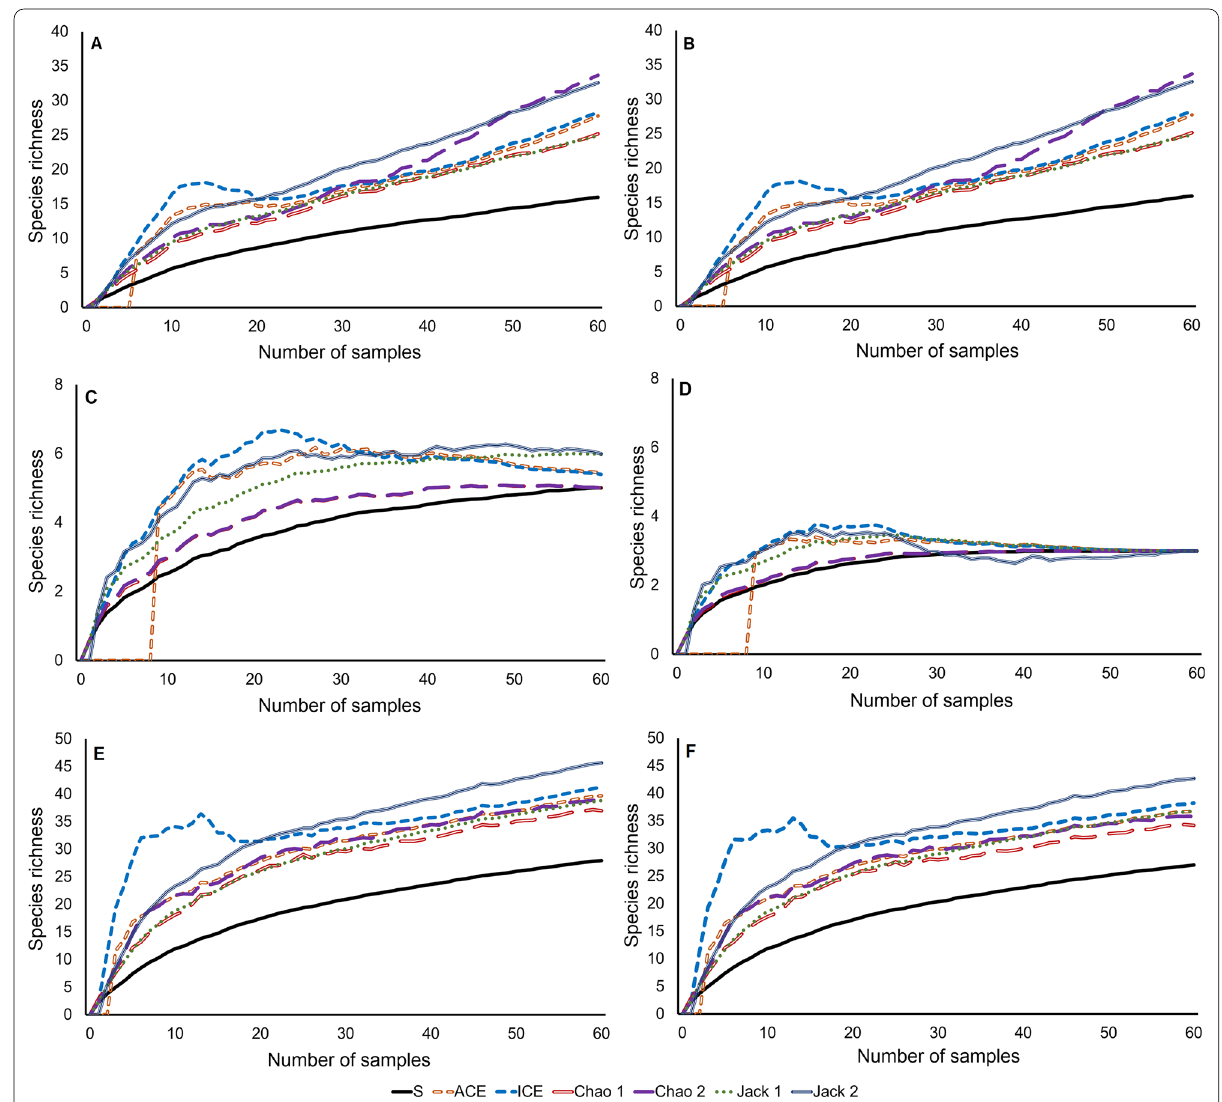
Fig. 2 Species richness estimation curves for Chaco National Park, Chaco, Argentina, with adult grassland; A – C – E : analyses with HTS; B – D – F : analyses without